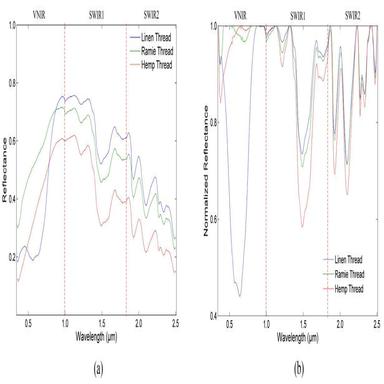
Spectral comparison between textile samples of bast, (a: reflectance spectra; b: CR spectra).